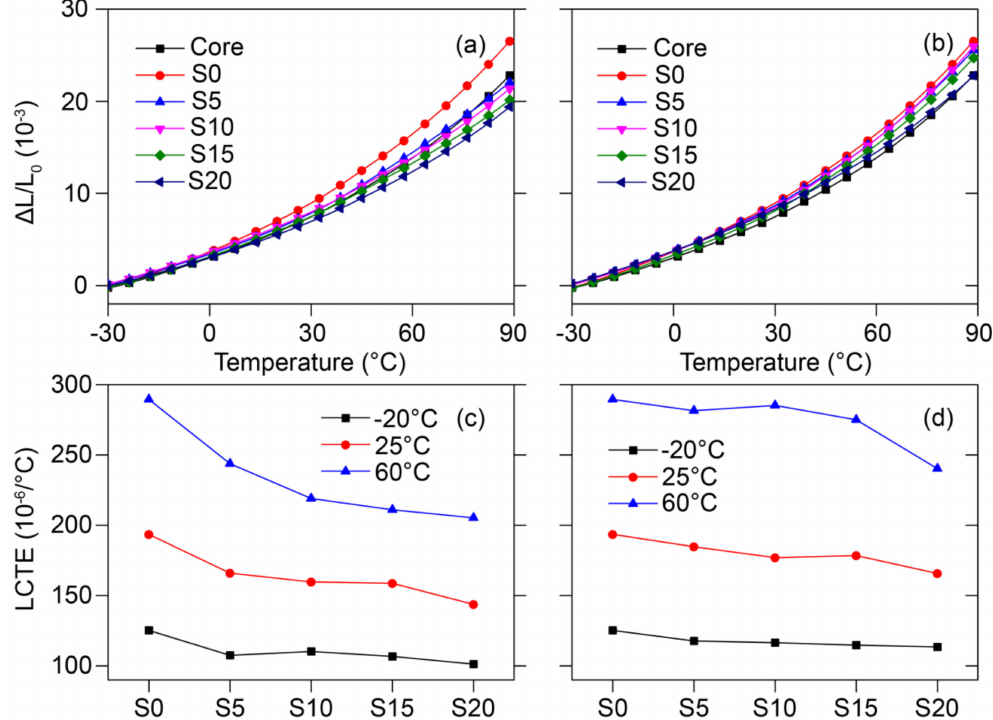
Figure 3. Thermal expansion strain of the cut Co-WPCs in the thickness direction: ( a ) nSiO 2 and ( b ) mSiO 2 fillers in shell layer, and LCTE as a function of silica content: ( c ) nSiO 2 and ( d ) mSiO 2 fillers in the shell